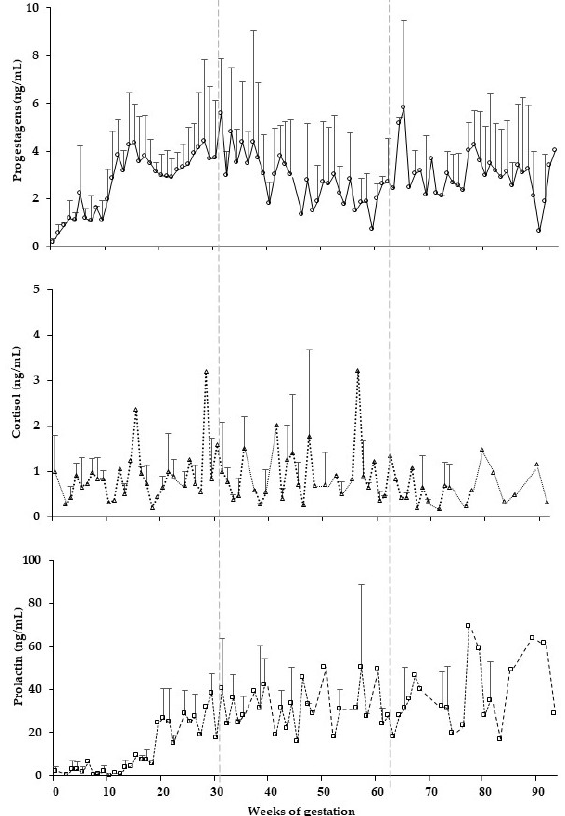
Figure 1. Mean ( ± SEM) concentrations of serum progestagens, cortisol, and prolactin in four pregnant elephants (E1–E4) over the weeks of gestation.